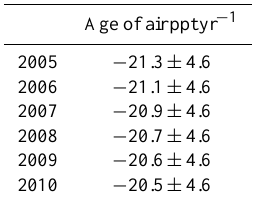
Table 1. The slope of the age of air against the volume mixing ratio of CFC-11 at the tropopause.